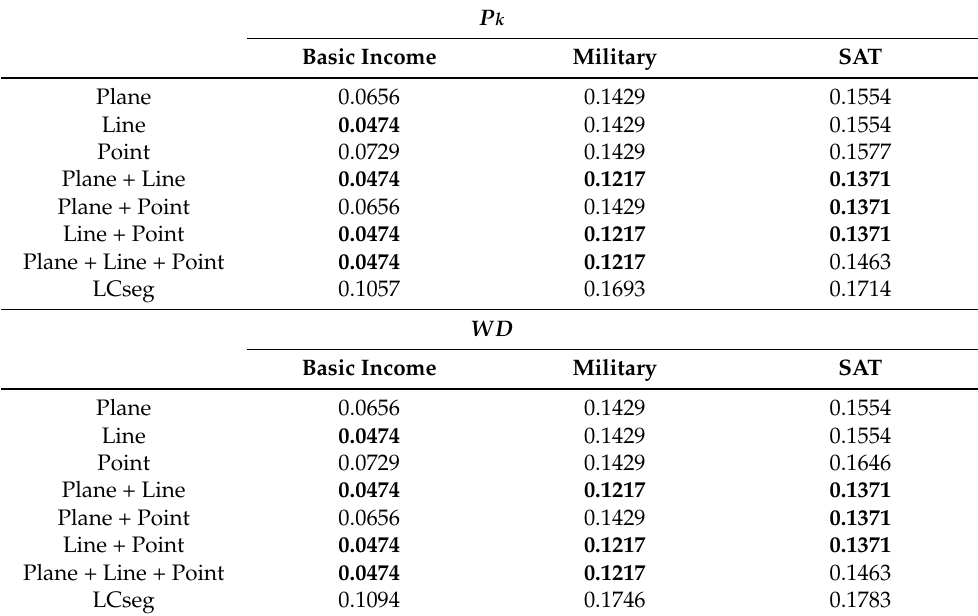
Table 3. CSseg P k and WD values when applying the debate consistency metrics of other-continuity, self-continuity, chain of arguments and counterarguments, and topic guide of